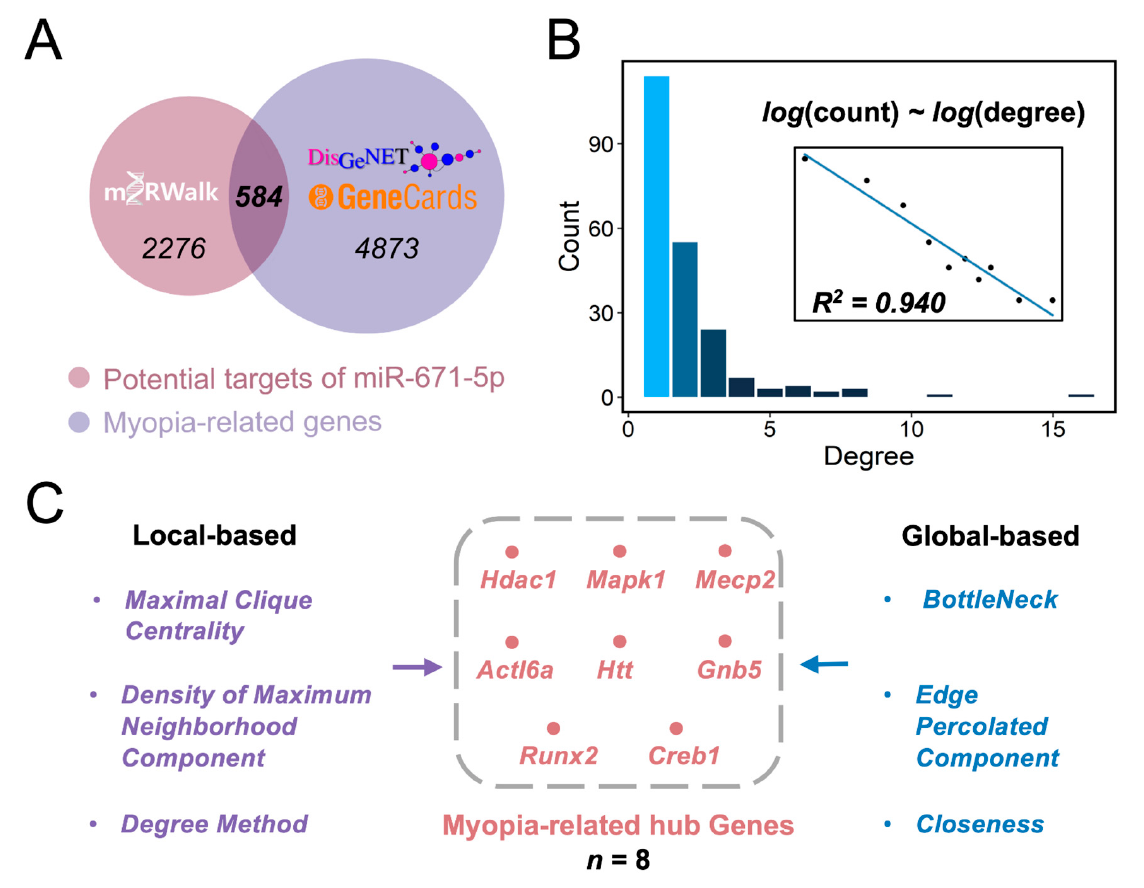
Figure 2. Identifying hub myopia-related target genes of miR-671-5p. ( A ) Venn diagram shows that a total of 584 miR-671-5p target genes are associated with myopia; ( B ) Node degree distribution shows that the PPI network follows a typical long-tail distribution; ( C ) The top eight hub genes ranked according to the calculation of node connectivity by CytoHubba.